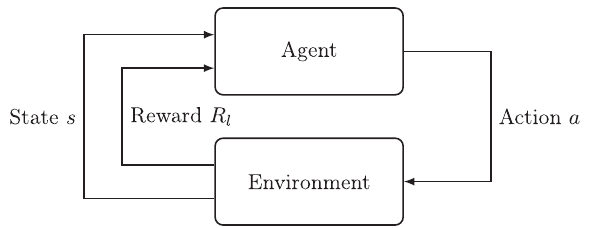
FIG. 2. Schematic representation of the RL cycle; The agent illustrates our RL algorithm. It can apply an action a to the environment. The environment depicts in our case, the simulation approximation which can calculate its new state s and the reward R l . It gives this information to the RL agent to decide the next